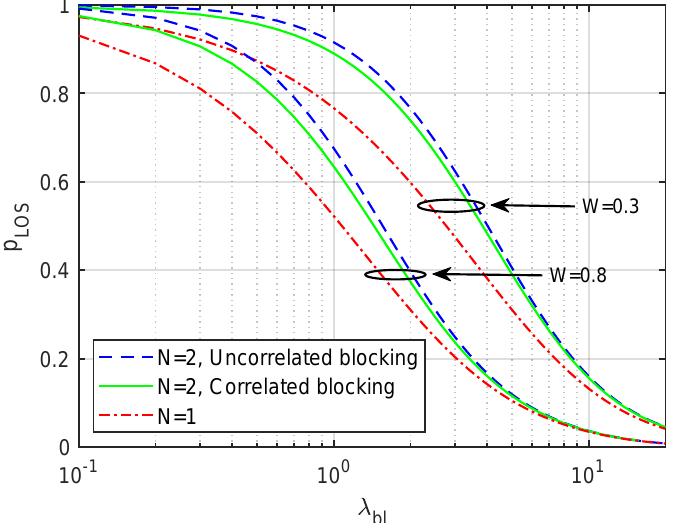
Figure 5. The variation of the spatially averaged p LOS over 1000 network realizations with respect to blockage density λ bl when N = 1,2, with and without considering blockage correlation at fixed base station density λ bs =